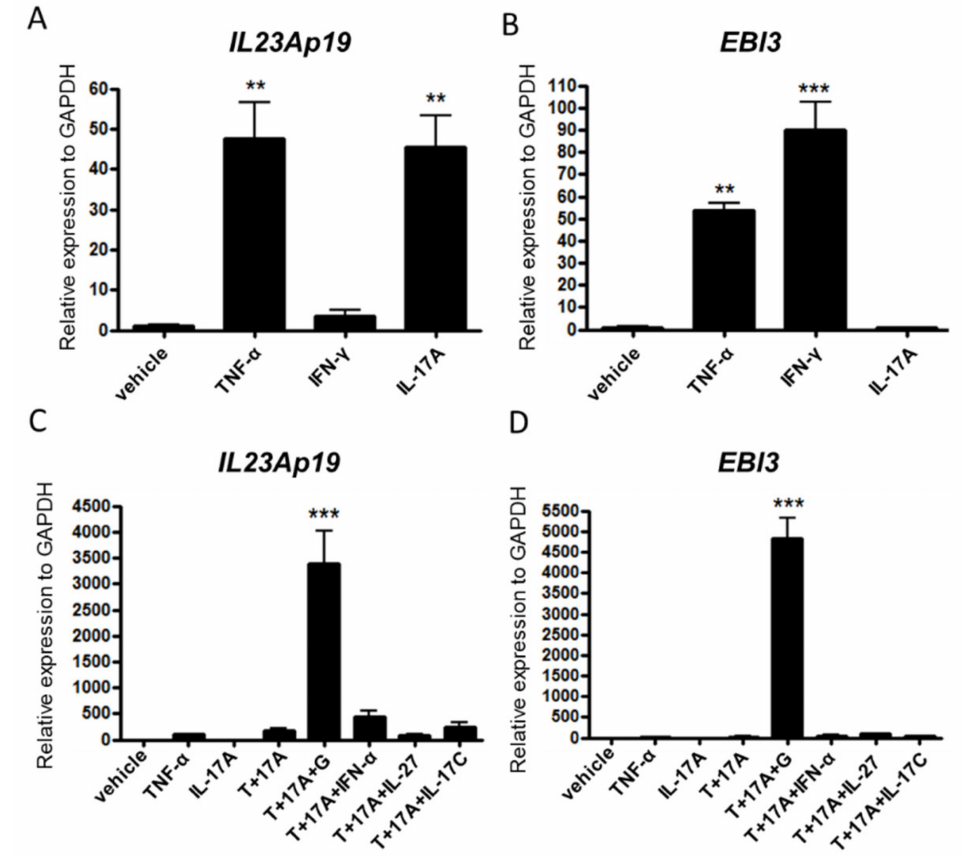
Figure 2. TNF- α , IL-17A, and IFN- γ synergistically induce IL23Ap19 and EBI3 expressions in NHEKs. ( A – D ) Normal human epidermal keratinocytes (NHEKs) were stimulated with ( A , B ) TNF- α (50 ng/mL), IL-17A (50 ng/mL), or IFN- γ (50 ng/mL), and ( C , D ) triple cytokine combinations of TNF- α , IL-17A, IFN- γ , IFN- α , IL-27 and/or IL-17C for 24 h. The relative mRNA expressions of IL23Ap19 and EBI3 to GAPDH were analyzed with quantitative real-time PCR (qPCR). ** p < 0.01, *** p < 0.001, T, TNF- α ; 17A, IL-17A; G, IFN- γ